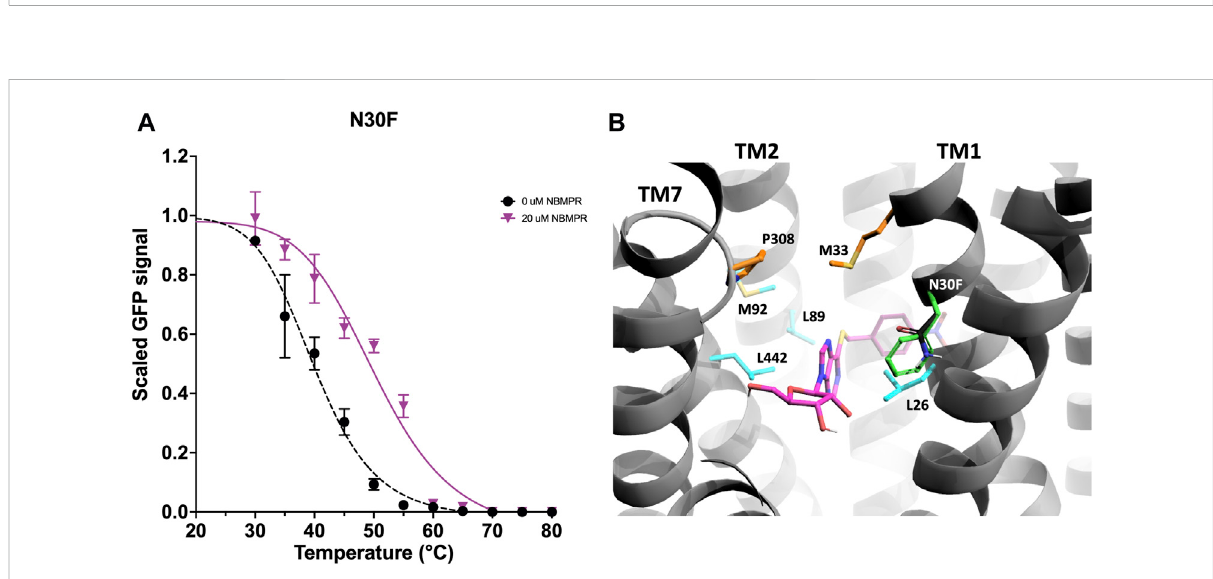
FIGURE 3 Investigation and rationalisation of variant N30F stabilisation of the NBMPR-bound state. (A) Data generation, fi tting and error analysis performedasdetailedinwildtype.N30F apo -statecurveswerecollectedasanaverageof10repeats,whereasNBMPR-boundcurveswerecollected as an average of 3 repeats. (B) A close-up view into the central cavity of hENT1 withTM8 removed for clarity. Side chains of residues involved in the surrounding of the purine moiety of NBMPR (pink) are shown in cyan. Residues involved in formation of the extracellular thin gate are shown in orange. Native N30 is shown in black, and variant N30F in